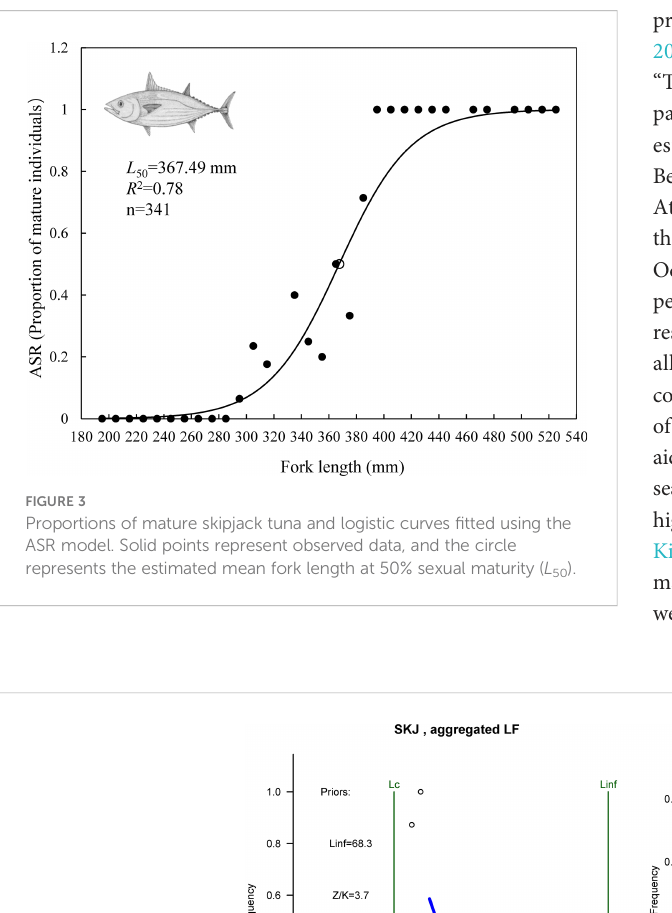
L opt , length where the maximum biomass of the unexploited stock is